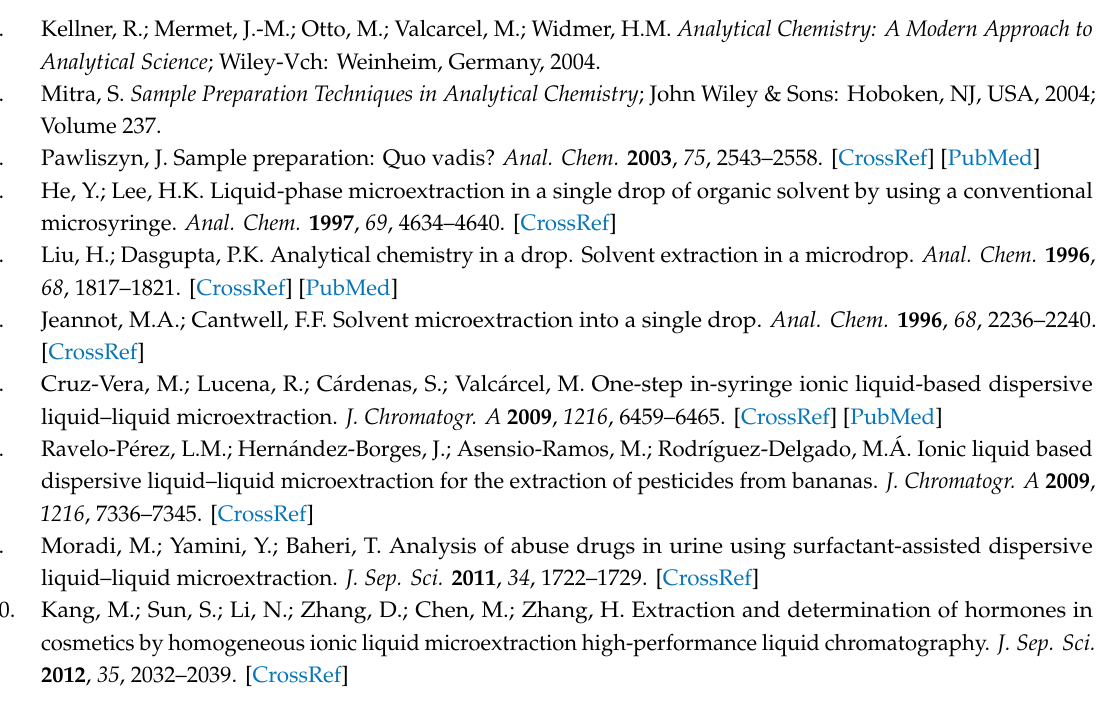
Figure S1: NMR spectrum of [HEtIMO] in CDCl 3 , Figure S2: NMR spectrum of [BuEtIMO] in DMSO, Figure S3: parameters, Table S1: Plackett–Burman table from the screening design for categorical parameters, Table S2: Complete ingredients lists of the four salves with an oil-in-water emulsion (O) and the four creams with a water-in-oil emulsion (W) acquired in local shops and Austrian web shops, Table S3: ANOVA results of the full central composite design for numerical parameters for linear and quadratic models, Table S4: Parameters for the determination of LOD and